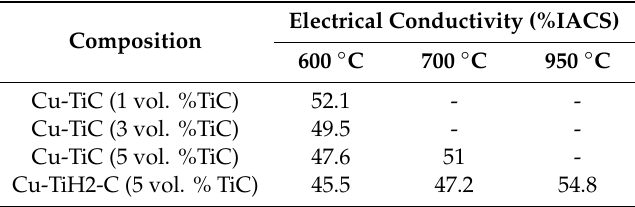
Table 4. Electrical conductivity value of composites sintered at di ff erent